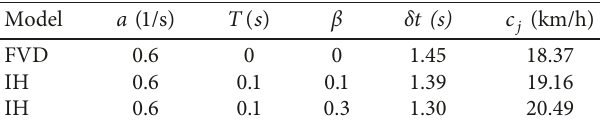
c j ) at traffic jam (